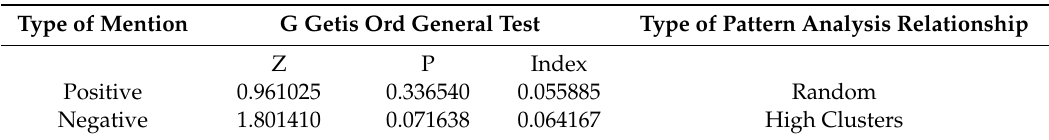
Table 5. G Getis Ord test on Value for